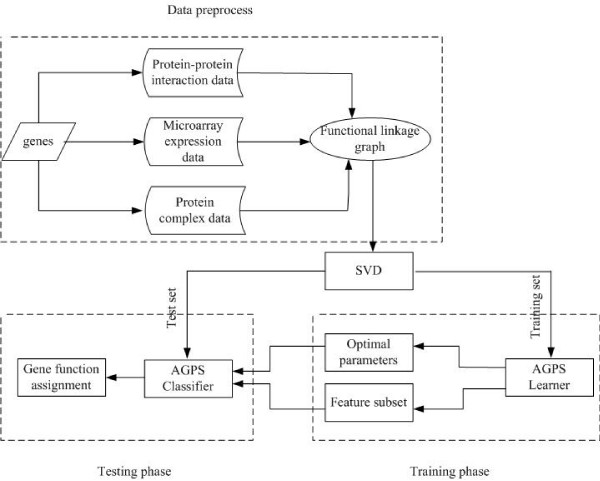
Schematic flow chart of the proposed method. First, the protein interaction data, gene expression profiles and protein complex data for yeast genes are integrated into one functional linkage graph; Then, the SVD technique is utilized to project the gene vectors into low-dimensional feature space by uncovering the dominant structure of the functional linkage graph; Finally, the AGPS algorithm is utilized to predict the functions of genes.